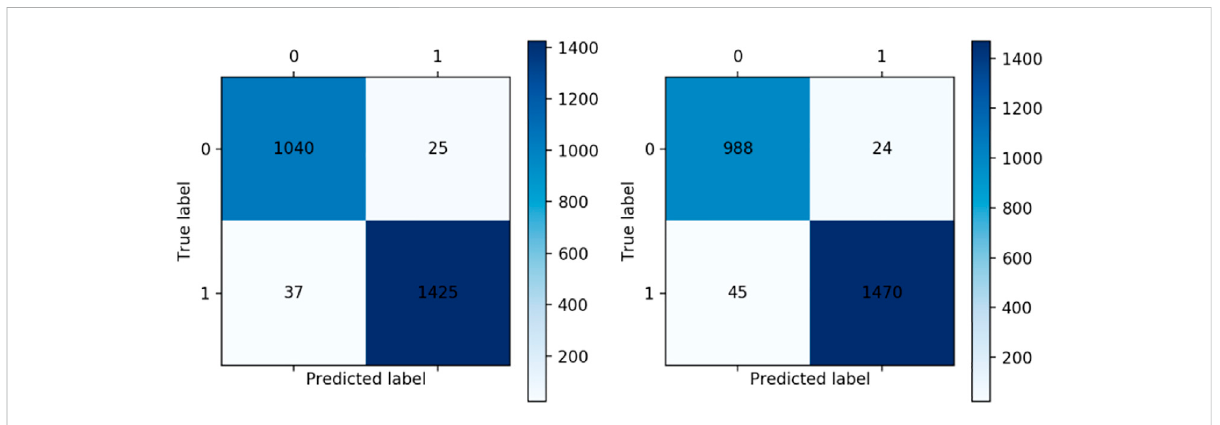
FIGURE 3 XGBoost 10-fold confusion Matrix.